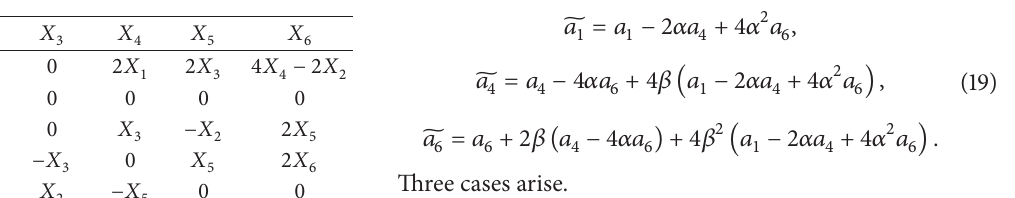
Table 1: Commutators of the admitted